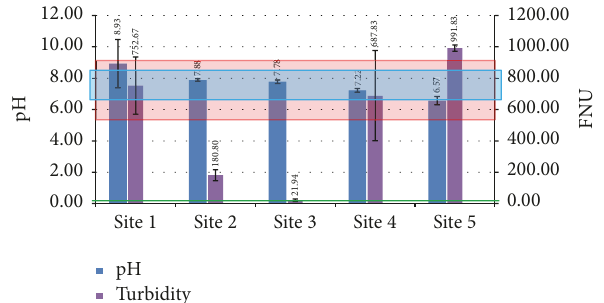
Figure 3: Graphs showing the pH and turbidity levels with their respective error bars on standard deviation, observed in the samples of 5 sites of this study, along with the ECR tolerable pH range (5.5–9) as shown by red rectangle, NDWQS pH range (6.5–8.5) as shown by blue rectangle, and NDWQS turbidity standard (10FNU) as shown by green